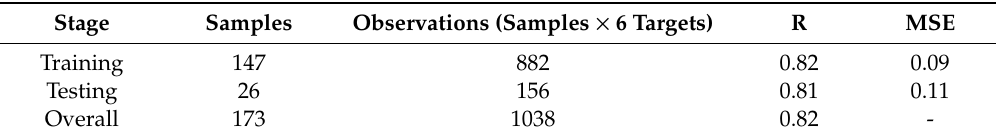
Figure 6. Artificial neural network overall model showing the observed responses (targets) in the x- axis and the predicted values (outputs) in the y-axis of the six volatile compounds. R = correlation coefficient. Table 4. Results from the artificial neural network model showing the numbers of samples and observations, correlation coefficient (R), and performance based on mean squared error (MSE) for each stage.